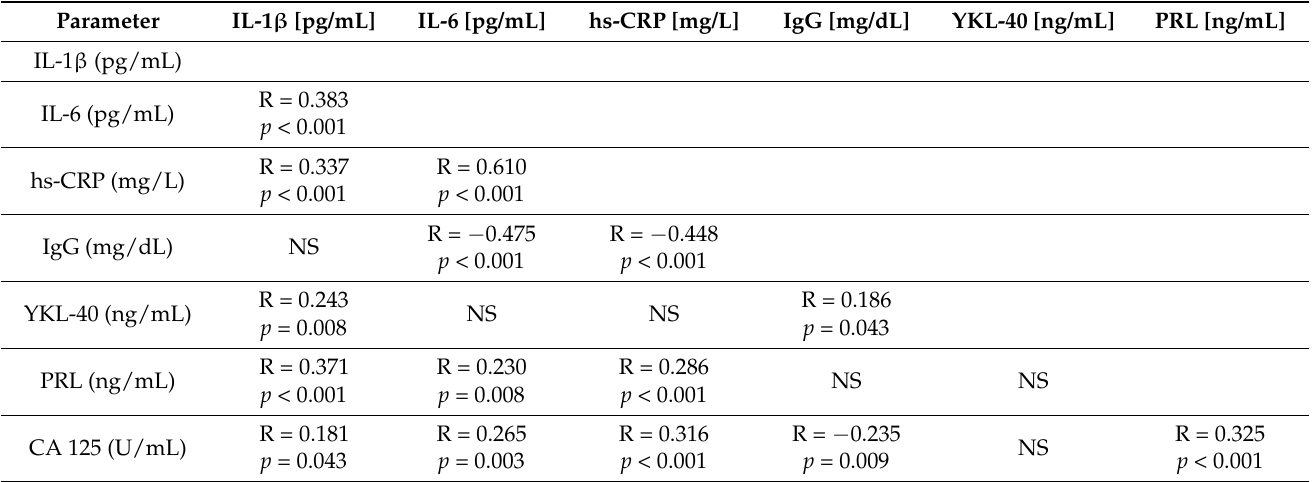
Figure 1. The values of determined concentrations of IL-1β, IL-6, hs-CRP, IgG, YKL-40, PRL and CA 125 ( A – G ), respectively), ( H ) is the legend. E — endometriosis, NE — non-endometriosis groups. Control – group of healthy volunteers, III E and IV E — third and fourth stage of endometriosis, respectively. A two-tailed p -Value of less than 0.05 was considered significant. The significant correlations between concentration values of the determined parame- ters for all studied subjects are shown in Table 2. Table 2. The correlations between concentrations of determined parameters.